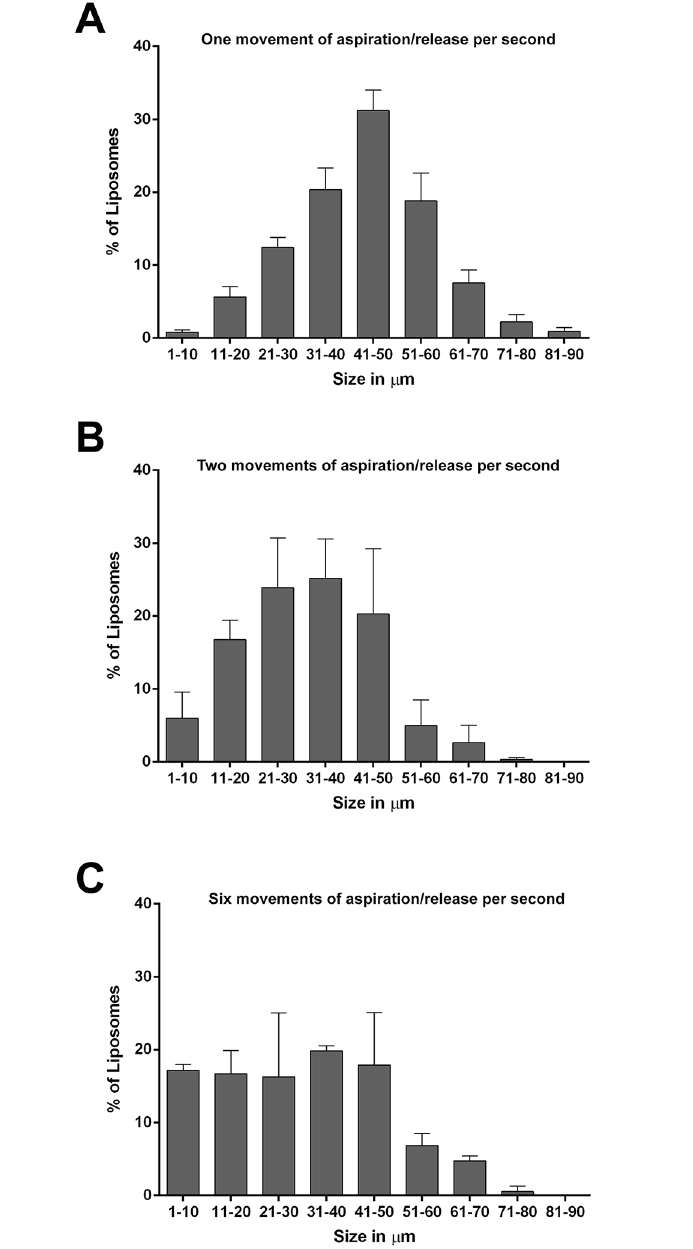
Fig 3. Size distribution of liposomes as function of aspiration/release speed. The micrp-emulsions were prepared by 30 aspiration/release cycles of the parasite suspension in a lipid-oil phase using a 1-ml micropipette. (A) one aspiration/release per second; (B) two aspiration/release per second; (C) six aspiration/ release per